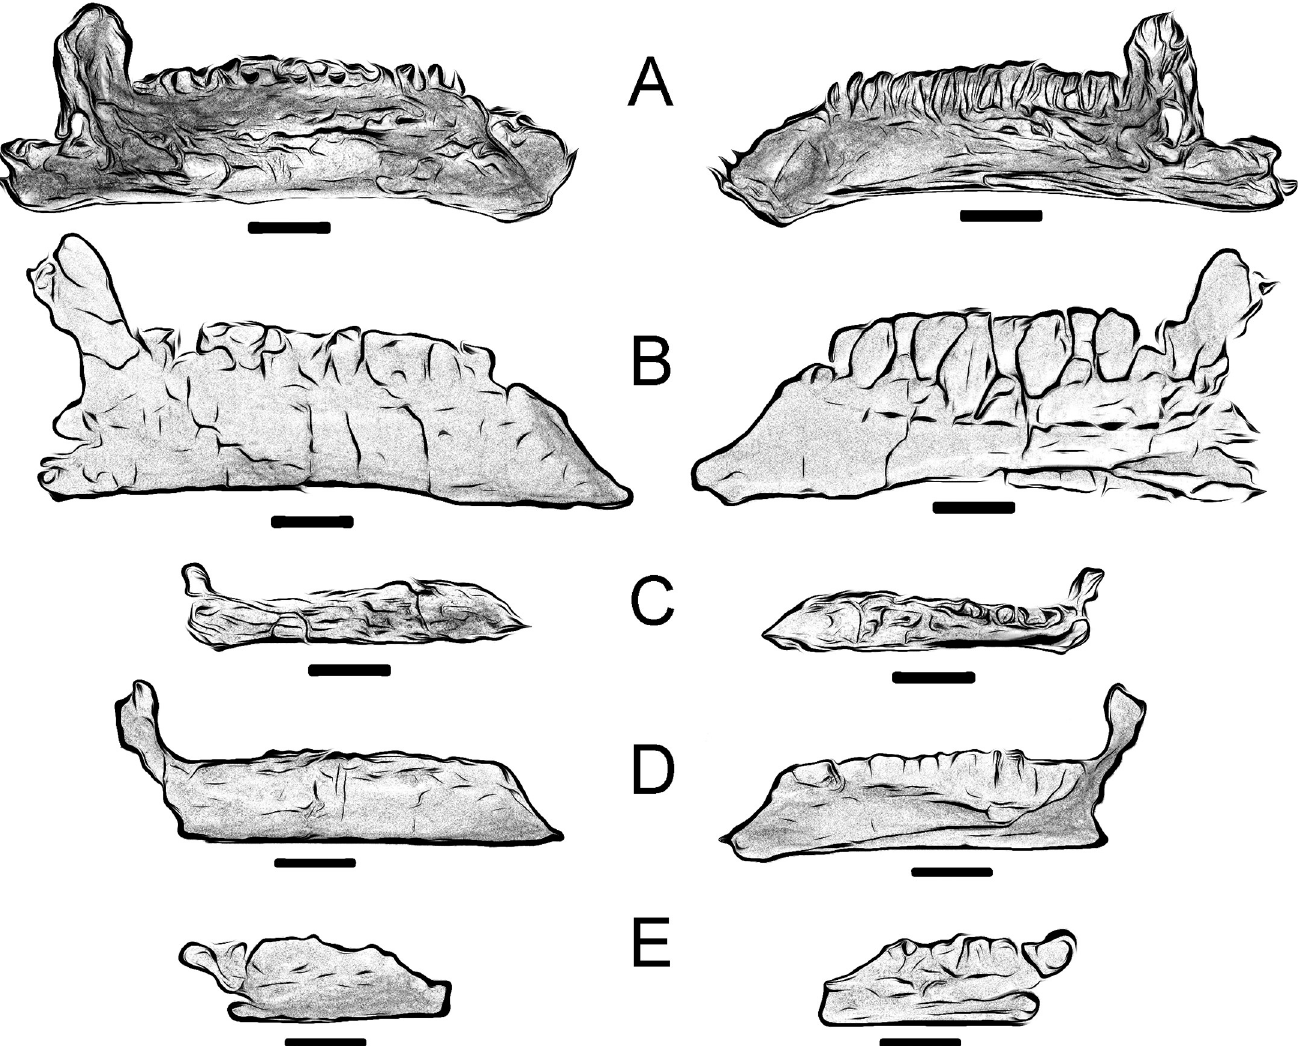
Fig 4. Straight ventral margin of the rostral ramus of some styracosternans from the Lower Cretaceous in comparison with P . sosbaynati gen. et sp. nov. Medial and lateral views. Scale bar equals 10 cm. (A) Iguanodon bernissartensis (IRSNB-1561, vertically reversed). (B) Lanzhousaurus magnidens (GSLTZP01-001, vertically reversed, drawing from Fig 1 in You, Ji and Li [33]). (C) Ouranosaurus nigeriensis (MNHN GDF 300, vertically reversed, drawing from Fig 29 in Taquet [31]). (D) Barilium dawsoni (NHMUK PV R 28660, drawing from Fig 2 in McDonald, Barrett and Chapman [36]). (E) Portellsaurus sosbaynati gen. et sp. nov.